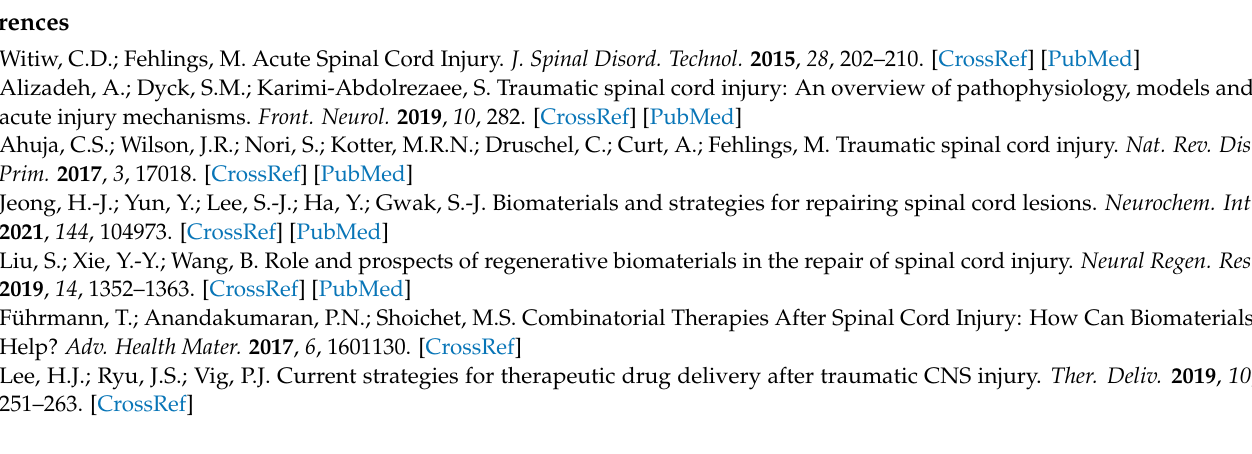
RGD6 distribution at 3 days post-injury; Figure S3: Qualitative microscopic analysis of (EIS) 2 - RGD6 distribution at 7 days post-injury; Figure S4: Qualitative microscopic analysis of (EIS) 2 -RGD6 distribution at 14 days post-injury; Figure S5: Qualitative microscopic analysis of (EIS) 2 -RGD6 distribution at 28 days post-injury; Figure S6: Qualitative microscopic analysis of (EIS) 2 -RGD6 structure at 3 days post-injury; Figure S7: Qualitative microscopic analysis of (EIS) 2 -RGD6 structure at 7 days post-injury; Figure S8: Qualitative microscopic analysis of (EIS) 2 -RGD6 structure at 14 days post-injury; Figure S9: Qualitative microscopic analysis of (EIS) 2 -RGD6 structure at 28 days post- injury; Table S1; Separate analysis of 21-point Basso, Beattie, and Bresnahan open-field test